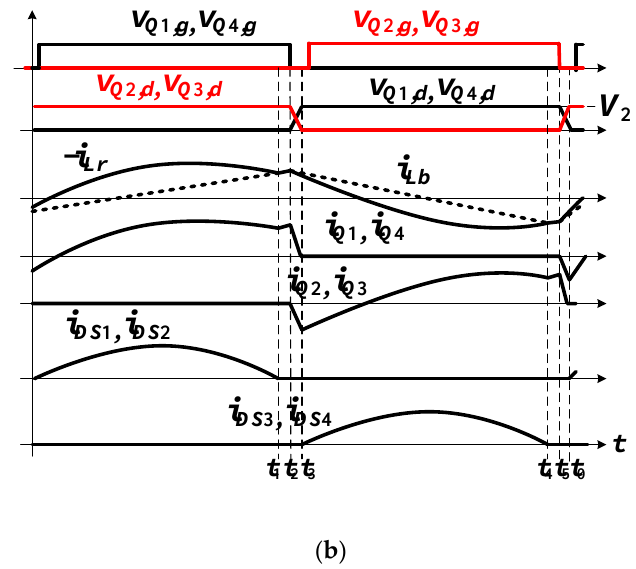
Figure 4. The proposed circuit operated at reverse power flow ( a ) the equivalent LLC resonant circuit ( b ) PWM waveforms.